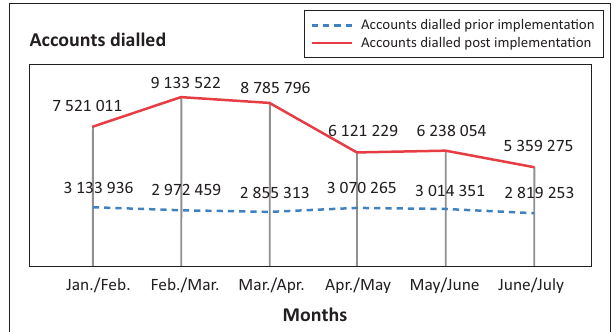
FIGURE 1: Number of accounts dialled.